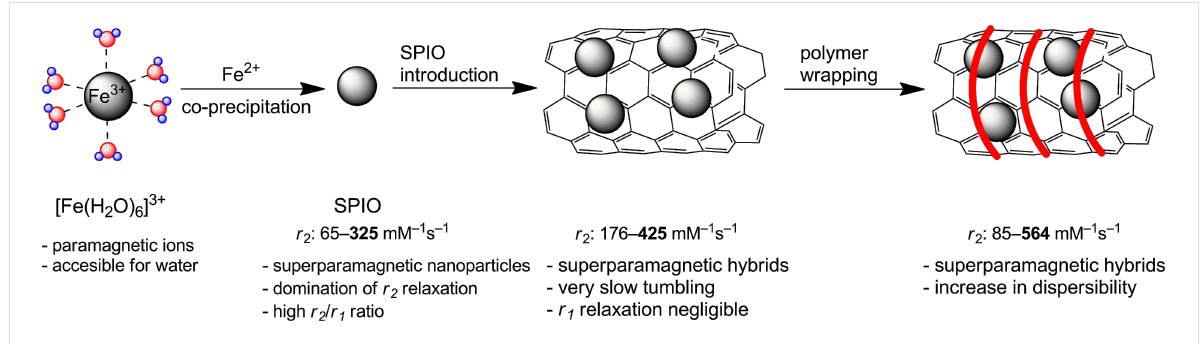
crease along with a growing magnetic field, but still a higher and less field-dependent one than [Gd(DTPA)] 2 −